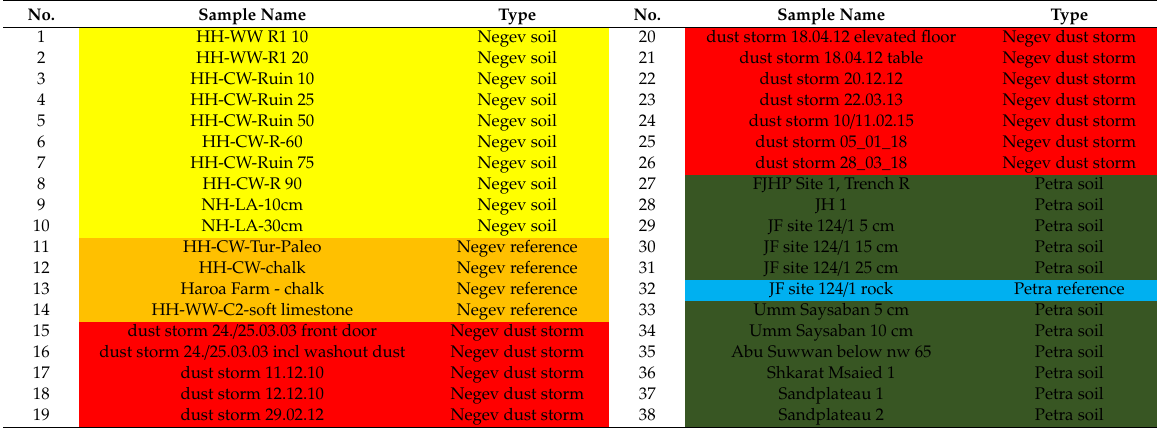
Table A10. Numbers, sample names, and rough classification of the sample types that were used for end-member modeling of grain sizes with EMMAgeo, as well as for principal component analysis (PCA) based on grain sizes and magnetic susceptibilities. The sample numbers match those of the robust end member scores presented in Figure 9. “Soil” summarizes ruin soils, paleosols, loessial aprons in the Negev, and the natural plateau soil in the Petra region. “References” geological units and “dust storms” comprise the samples collected in dust collectors. These types were utilized for the non-parametric random forest approach to test whether grain size distributions and magnetic susceptibilities are suited for predictions of the sample type. Background colors refer to sample types: yellow for Negev soils, orange for Negev references, red for Negev dust storms, brown for Petra region soils, blue for Petra region reference samples, and gray for Petra region dust storm